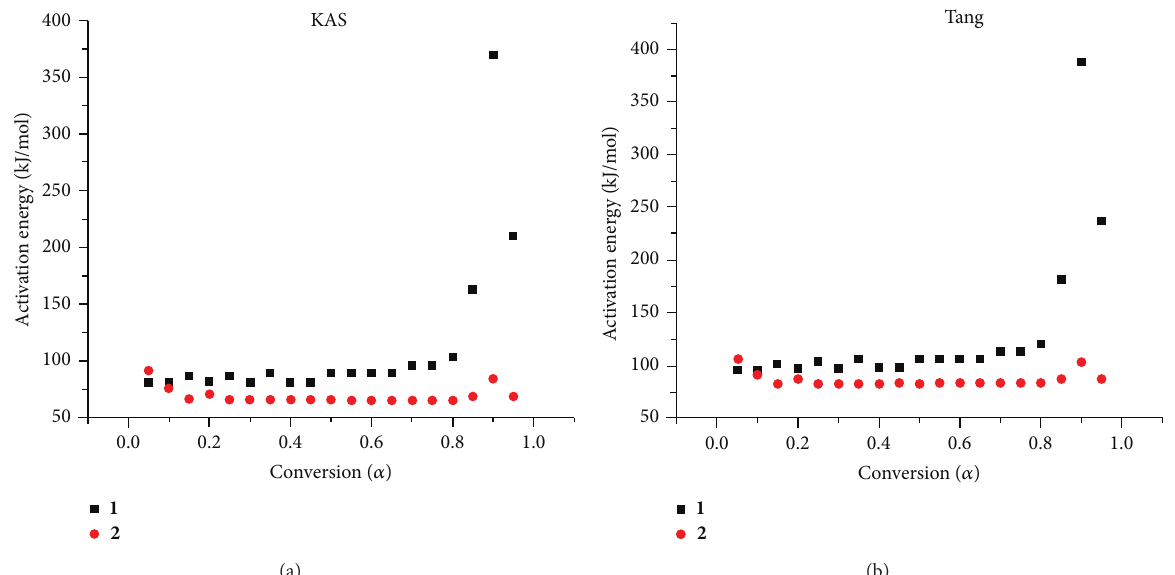
Figure 4: (a) The plot of activation energy ( 𝐸 ) versus the degree of conversion ( 𝛼 ) for KAS method of compounds 1 and 2 . (b) The plot of activation energy ( 𝐸 ) versus the degree of conversion ( 𝛼 ) for Tang method of compounds 1 and 2 .